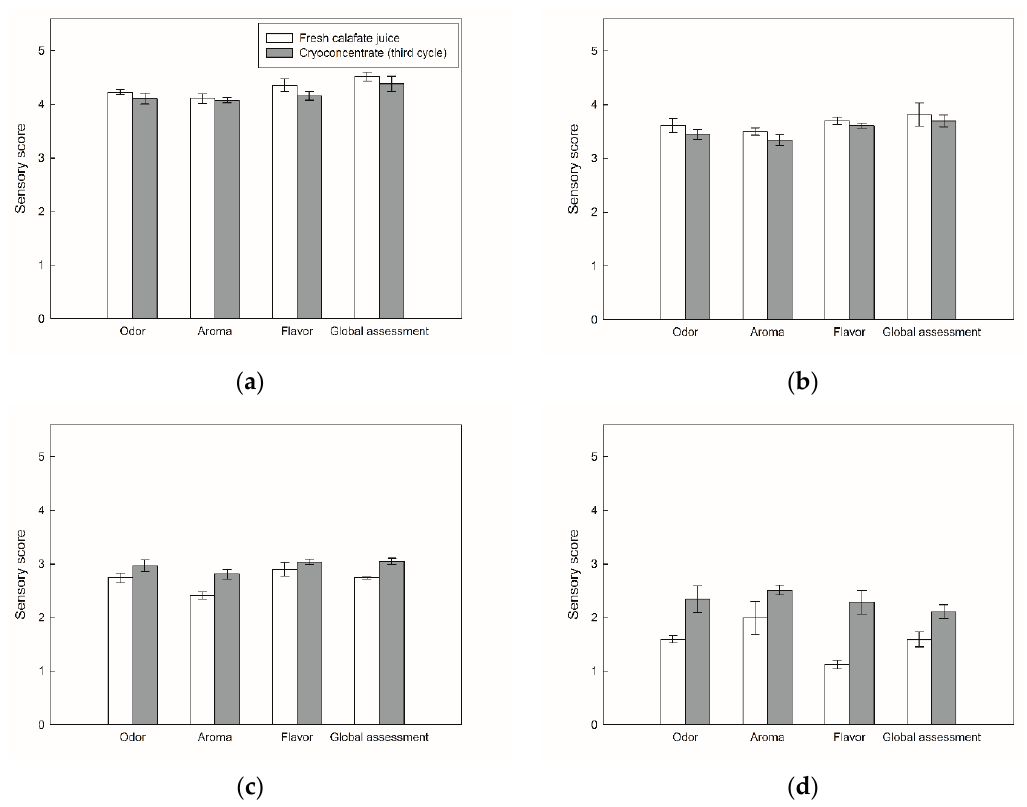
Figure 3. Sensory attributes between fresh calafate juice and reconstituted cryoconcentrated sample at the third cycle: ( a ) day 0; ( b ) day 7; ( c ) day 14; and ( d ) day 21. the third cycle: ( a ) day 0; ( b ) day 7; ( c ) day 14; and ( d ) day